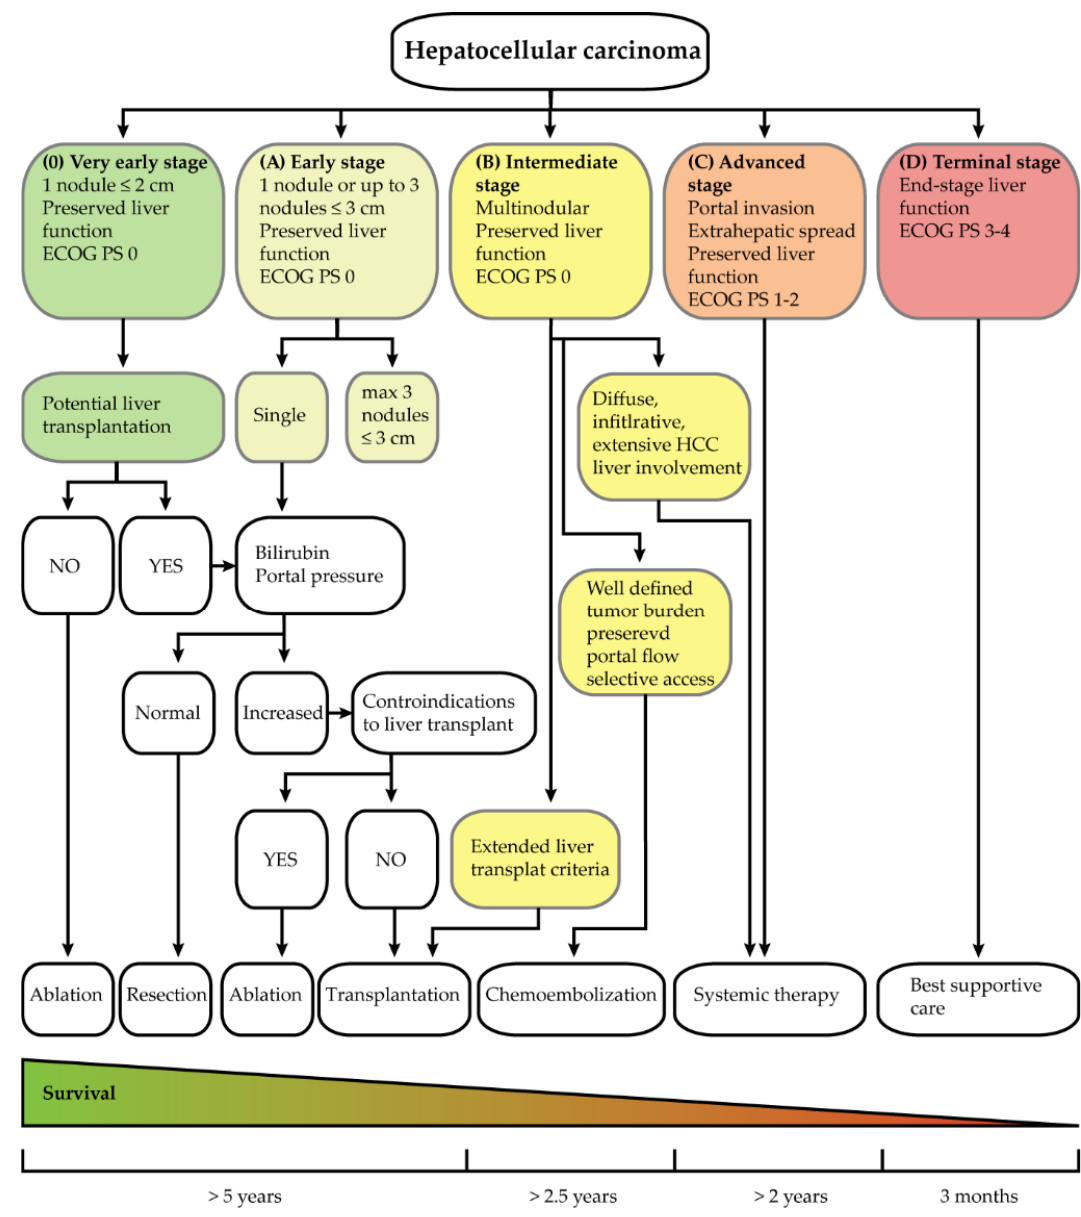
Figure 2. Barcelona Clinic Liver Cancer (BCLC) staging and treatment strategy. The scheme shows the classification of HCC and the possible treatments for each stage. Figure based on the BCLC group guidelines of